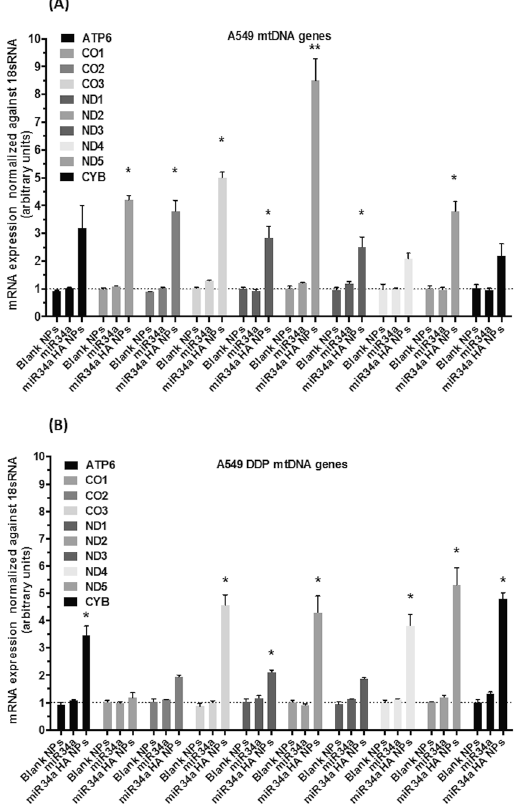
Figure 6. Effect of miR34a transfection with HA-based nanoparticles on mRNA content of mitochondrial DNA (mtDNA) encoded genes. A quantitative real time polymerase chain reaction (qRT-PCR) assay was used with (A) wild-type A549 and (B) cisplatin resistant A549DDP cells post-transfection with HA-PEI/HA-PEG- nanovectors encapsulated miR34a. Normalized to 18 s ribosomal RNA and untreated control samples using relative quantification by delta(delta(Ct) method. Blank NPs–Blank HA-PEI/HA-PEG nanoparticles, miR34a - Naked miR34a without encapsulation, miR34a HA-NPs–microRNA34a encapsulated in HA-PEI/HA-PEG nanoparticles. Results are expressed in units (mean + / − standard error of mean [SEM]); * indicates comparison against control = 1. One-way ANOVA followed by Post-hoc t-test with multiple comparisons, * p < 0.05, ** p < 0.01; n =